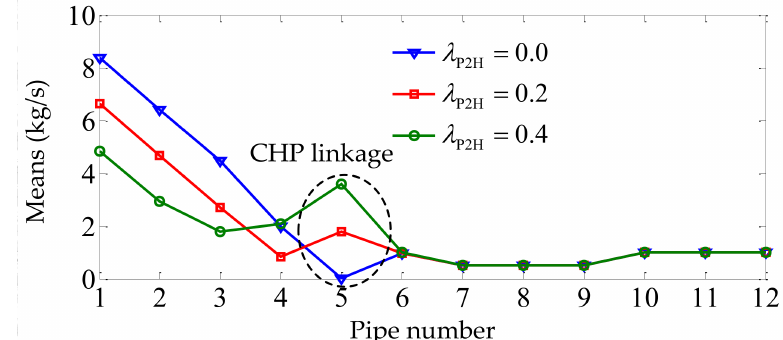
Figure 14. Mean values of mass flow rates within pipes in the heating network.